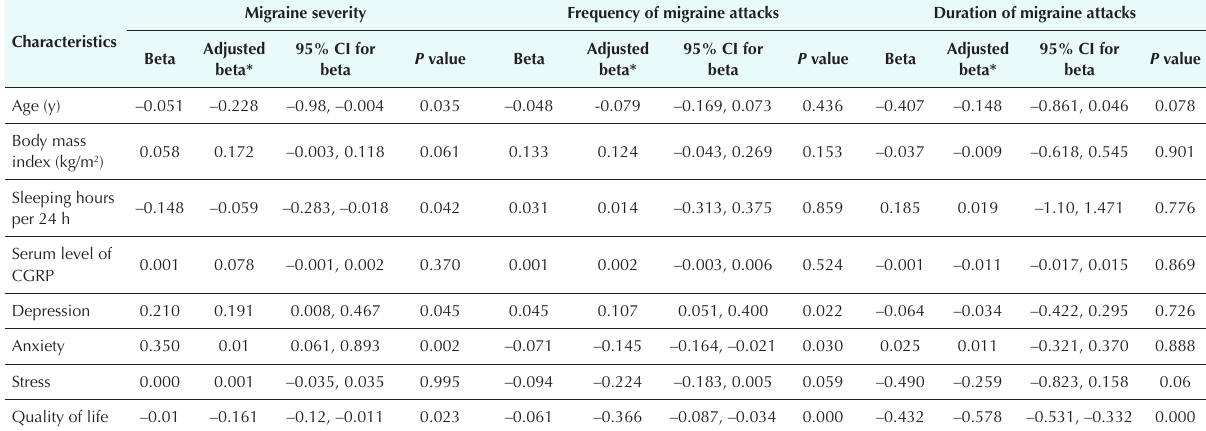
Table 2. The results of linear regression analysis to assess the relationship of participants’ characteristics with migraine characteristics